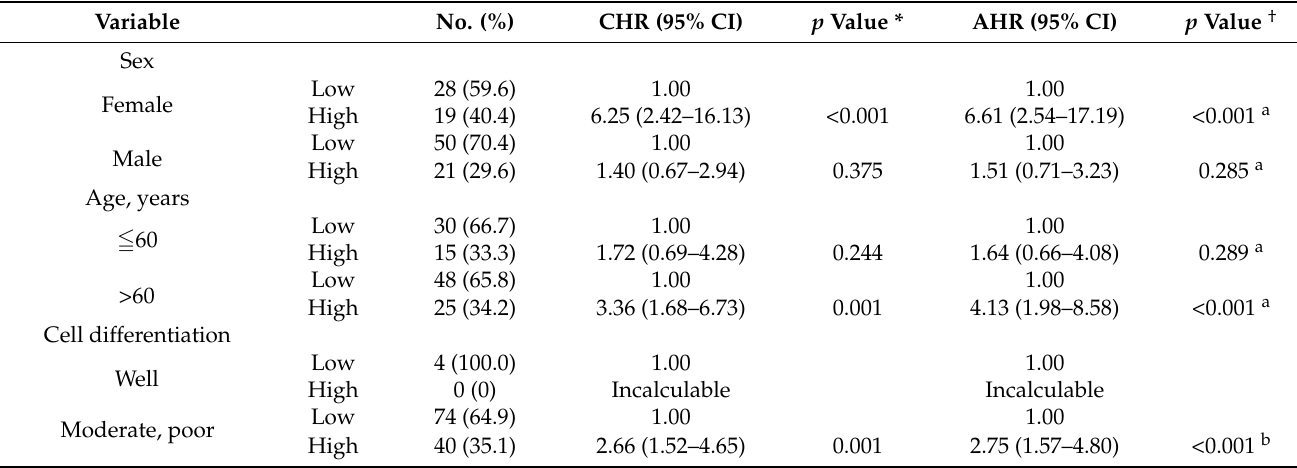
Table 2. Association of the ATG5 protein level on the overall survival according to demographic and clinicopathologic factors in CRC